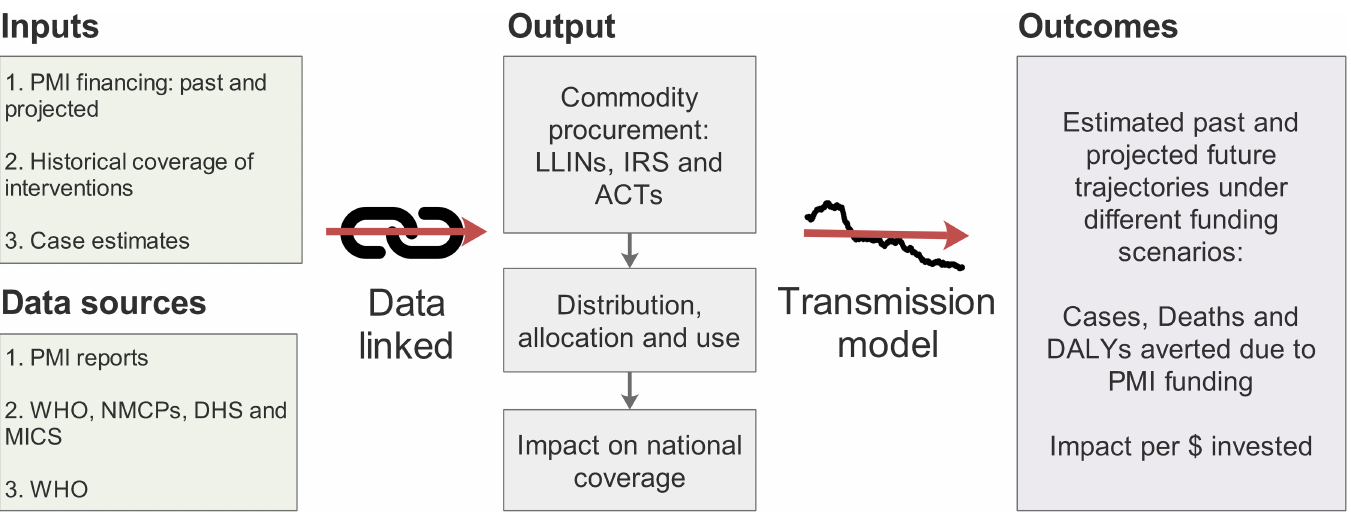
Fig 1. Schematic of the modelling process. Data inputs and sources (left column)are combinedand linked to estimate the contributionof PMI and the impact of fundingcuts on national-level intervention coverage (middlecolumn). These estimates are then used as inputs in a dynamic transmission model to estimate the impact of changesin interventioncoverageon epidemiologicaloutcomes(right column). ACT, artemisinin combination therapy; DALY, Disability AdjustedLife Year; DHS, Demographic and Health Survey; IRS, indoorresidualspraying;LLIN, long-lastinginsecticidetreated net; MICS, MultipleIndicator Cluster Surveys; NMCP, NationalMalaria ControlProgramme;PMI, President’s Malaria Initiative.